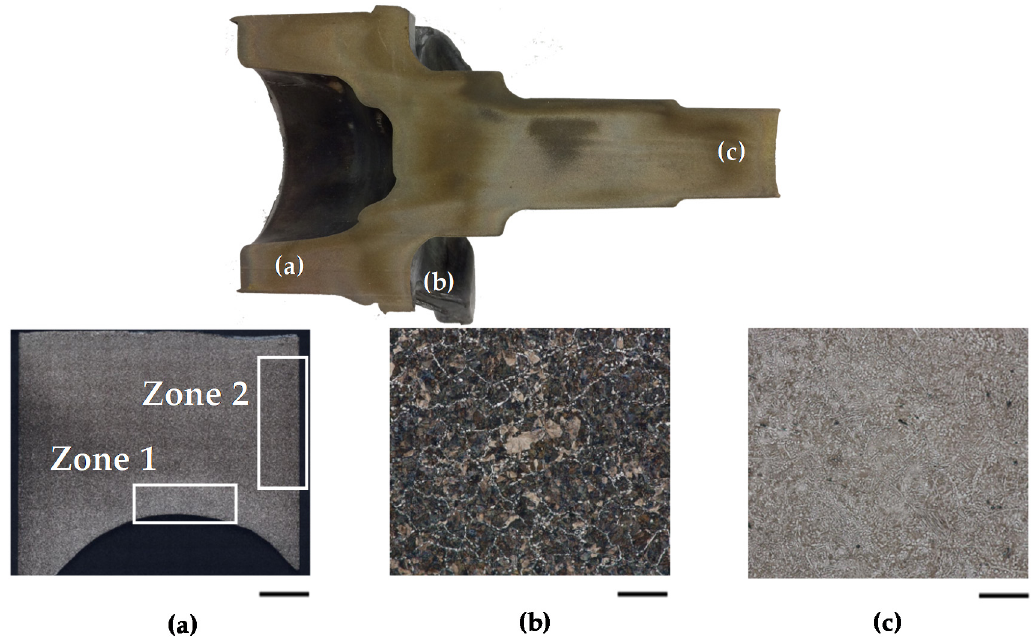
Figure 11. The manufactured semi-solid forming (SSF) component of 44MnSiVS6 cut in half and the microstructures at different positions: ( a ) bottom, ( b ) middle, and ( c ) axle. The scale bar means 5 mm for ( a ) and 100 μ m for ( b ) and ( c ).